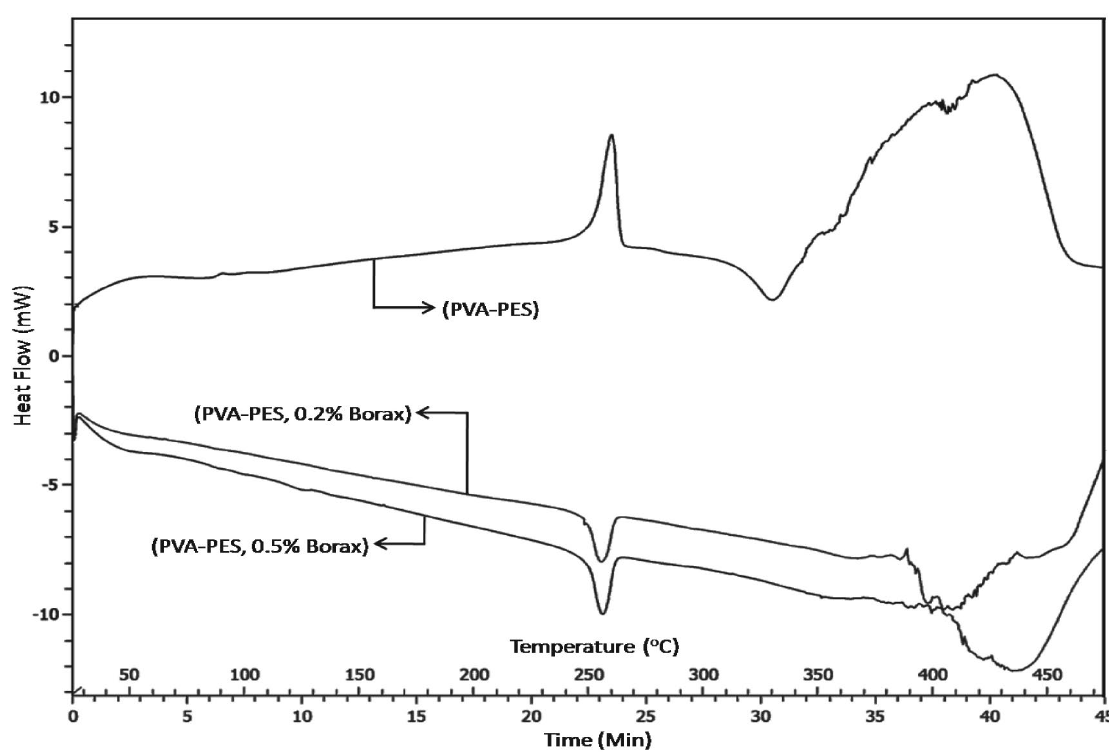
Fig. 4. Differential Scanning Calorimetry thermograms of the prepared composite membranes used in the present